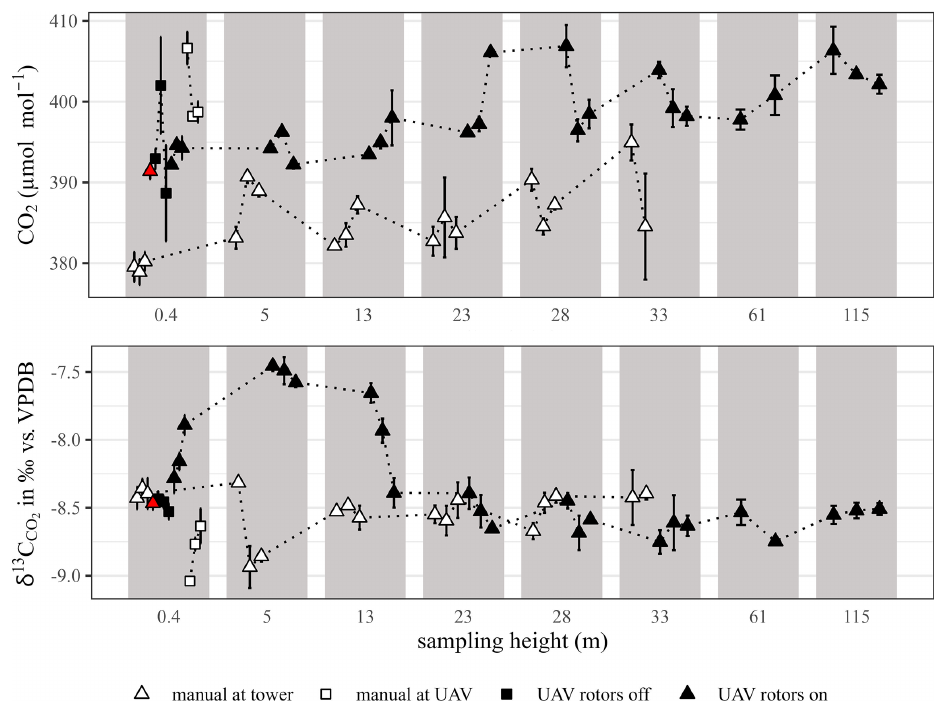
Figure 5. Comparison of CO 2 molar ratios and δ 13 C values obtained by UAV-based (black) and manual sampling (white, red) at the forest demonstration site. Dotted lines indicate consecutive sampling. To better distinguish samples of the same height, they are shown in gray rectangles, each encompassing a discrete sampling height according to the x axis. Error bars were obtained from measurement triplicates ( n =